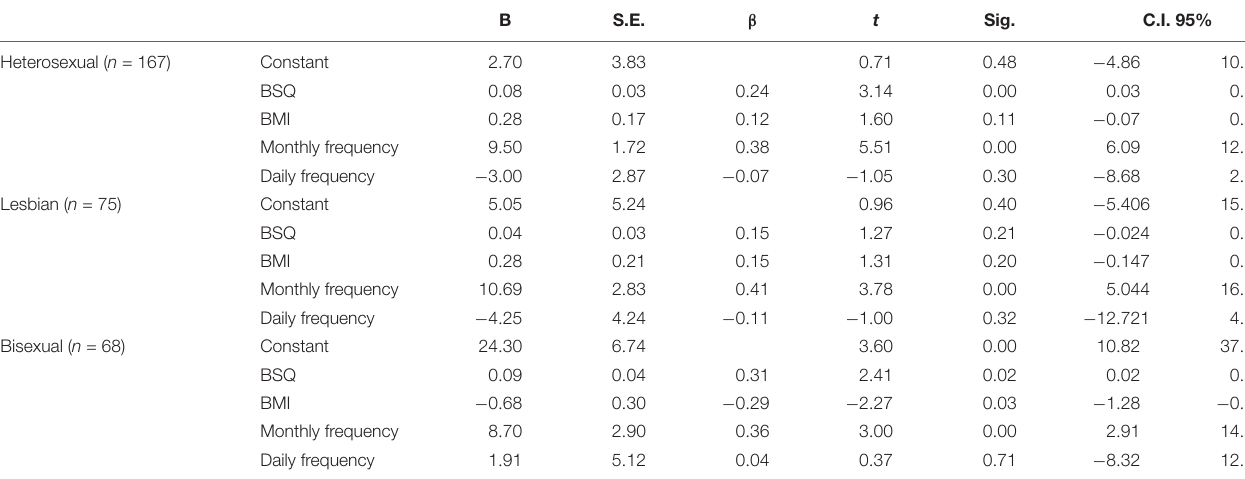
TABLE 4 | Parameter estimates in the multiple regression analyses for heterosexual, lesbian, and bisexual